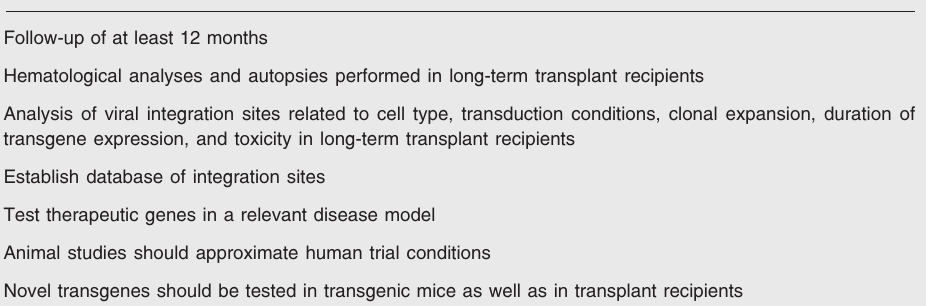
Table 3. Recommendations by the American Society of Gene Therapy for hematopoietic stem cell gene transfer studies in animal models. Follow-up of at least 12 months Hematological analyses and autopsies performed in long-term transplant